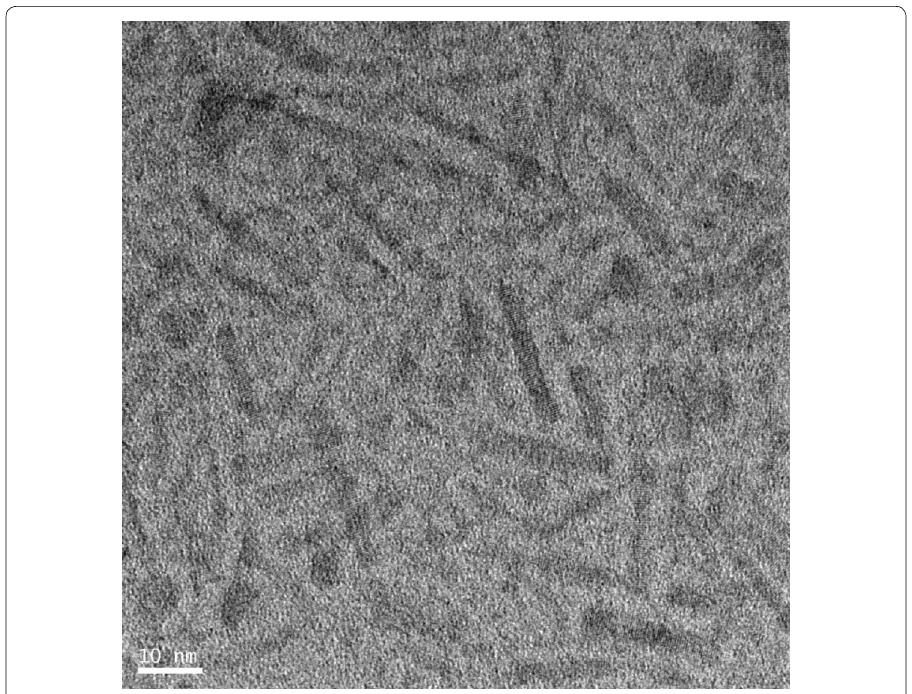
Fig. 2 HR‑TEM images of tungsten bronze